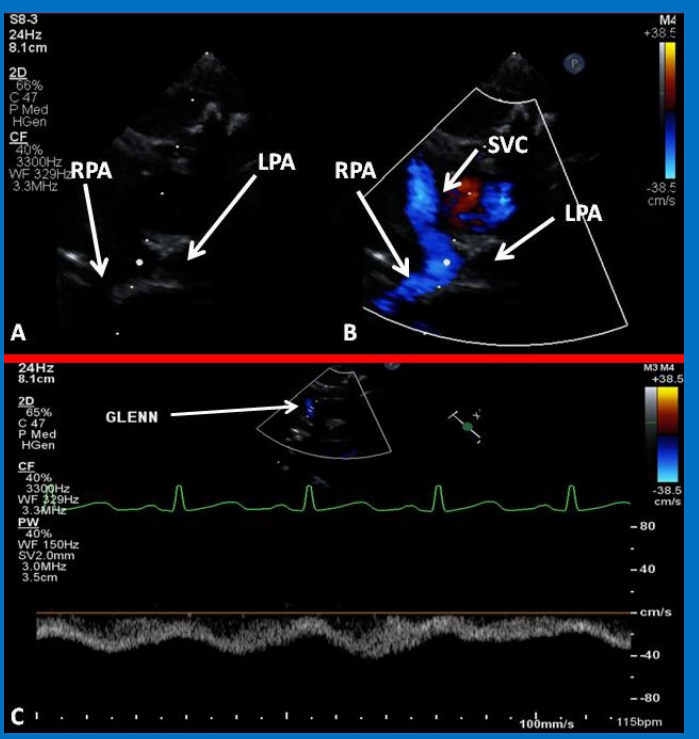
Figure 26. ( A , B ) Selected video frames from suprasternal notch view demonstrating bidirectional Glenn shunt. In ( A ), the right (RPA) and left (LPA) pulmonary arteries are shown by 2D. The superior vena cava (SVC) was not clearly seen. In ( B ), the SVC is shown emptying into the RPA by color Doppler ( B ). The LPA did not show color flow because it was in a different plane of imaging than RPA, but is seen by 2D ( B ). ( C ) Low Doppler flow velocity across the Glenn shunt indicates unobstructed flow.